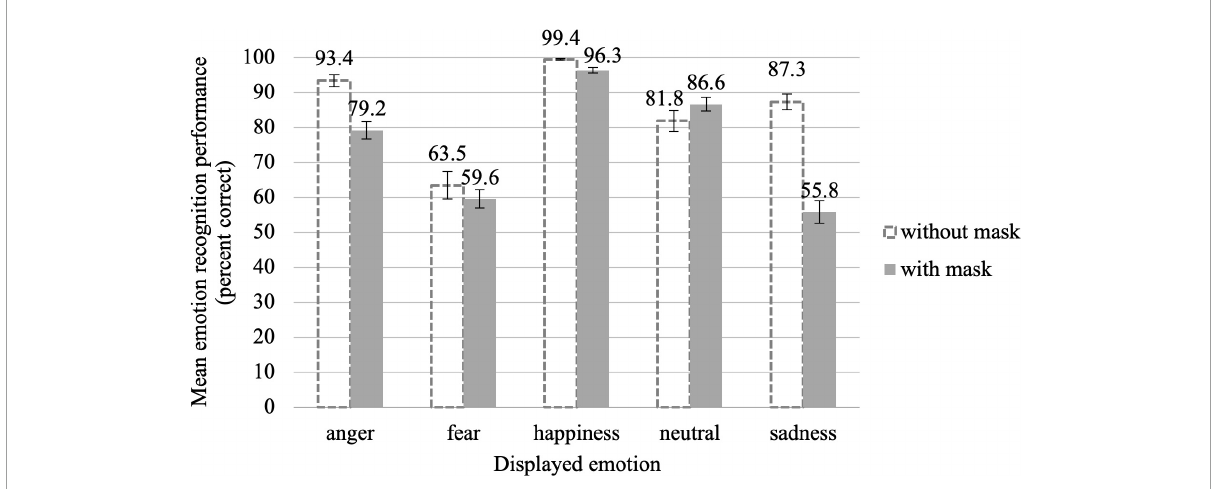
FIGURE7 Mean emotion recognition performance in percent correct for uncovered faces (dashed bars; Exp. 1) and masked faces (filled bars; Exp. 2) as a function of the displayed emotion, averaged across all gaze directions and head orientations. Error bars indicate the standard error of the mean (SEM) of the 39 and 45 individual data points per displayed emotion,